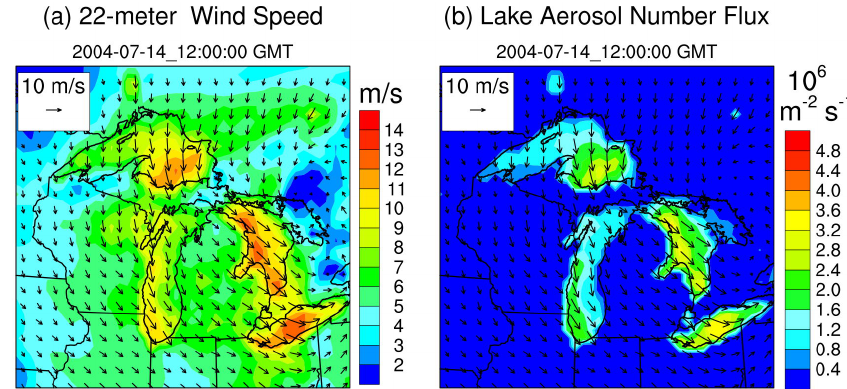
Fig. 2. Results for 12:00:00GMT (8 am Eastern Daylight Time) on 14 July 2004: (a) 22-m wind speed (ms − 1 ), and (b) wind-generated aerosol number flux (10 6 m − 2 s − 1 ) over the lakes using the parameterization of Geever et al. (2005) (see Sect. 2.3 text), with wind vector overlay.